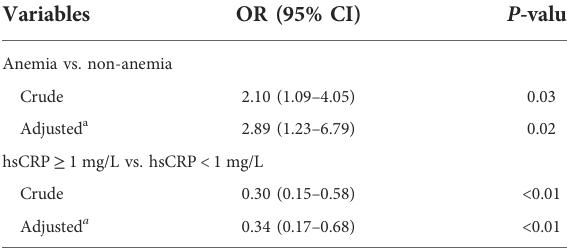
TABLE 2 Association of hsCRP and anemia with AKI.